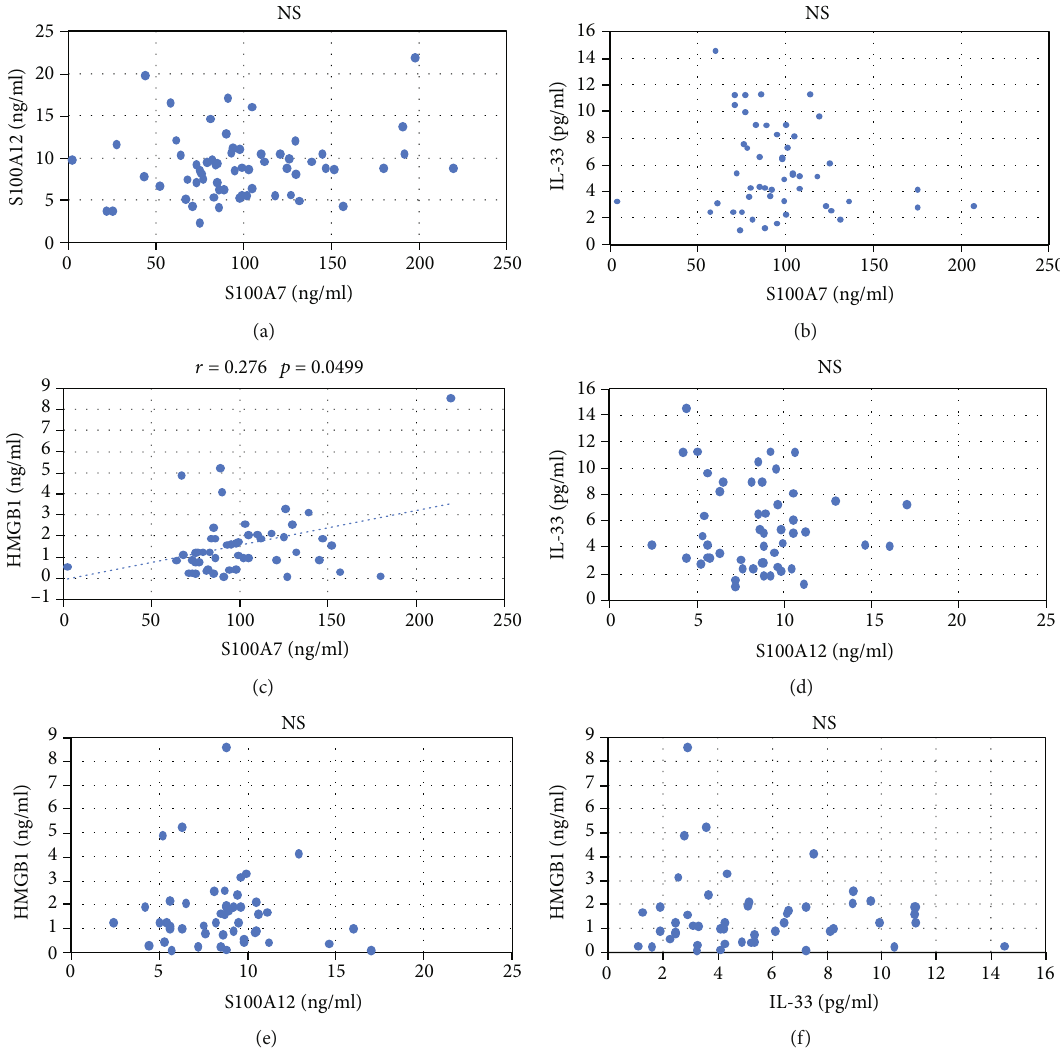
Figure 2: This fi gure depicts possible correlations between each of the alarmins in the group of patients. Statistical signi fi cance was found using Spearman ’ s rank correlation test between HMGB1 and S100A7 ( r = 0 : 276 , p = 0 : 0499